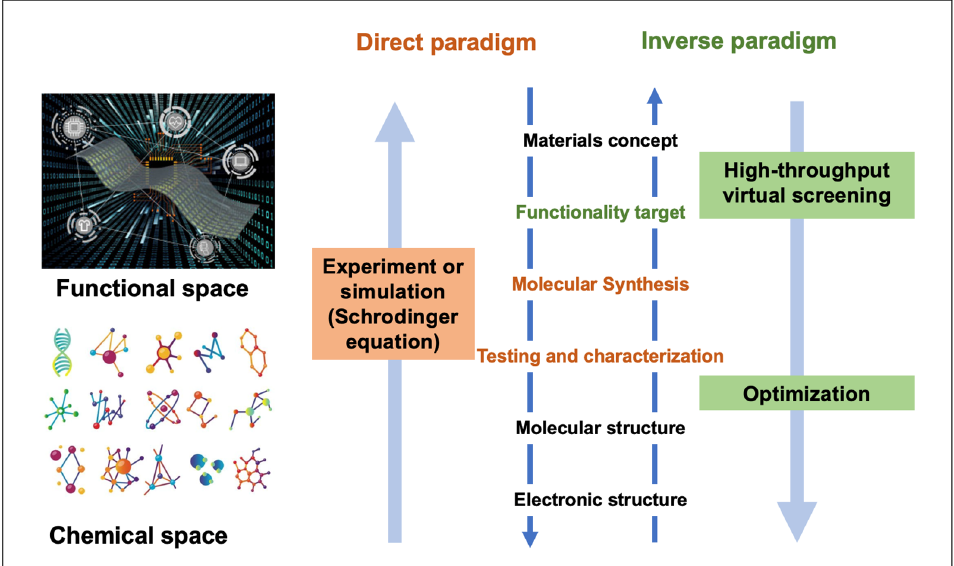
Figure 1. Schematic of the different approaches toward molecular design.